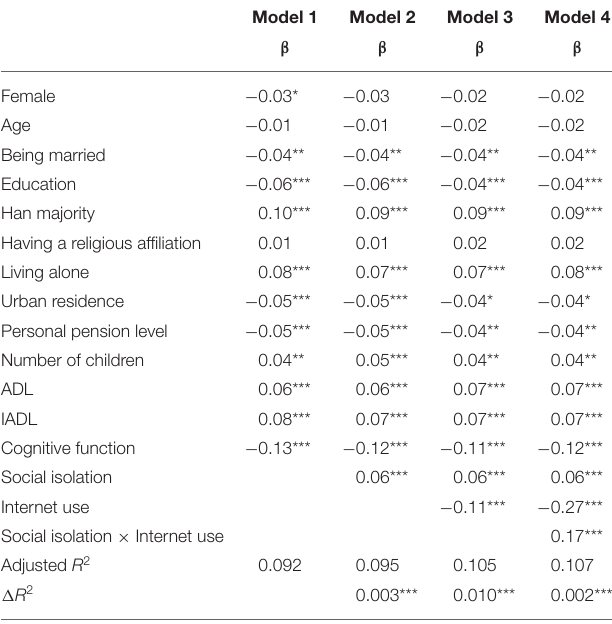
TABLE 3 | A hierarchical regression analysis for moderating effects in the relationship between social isolation and depressive symptoms ( N =